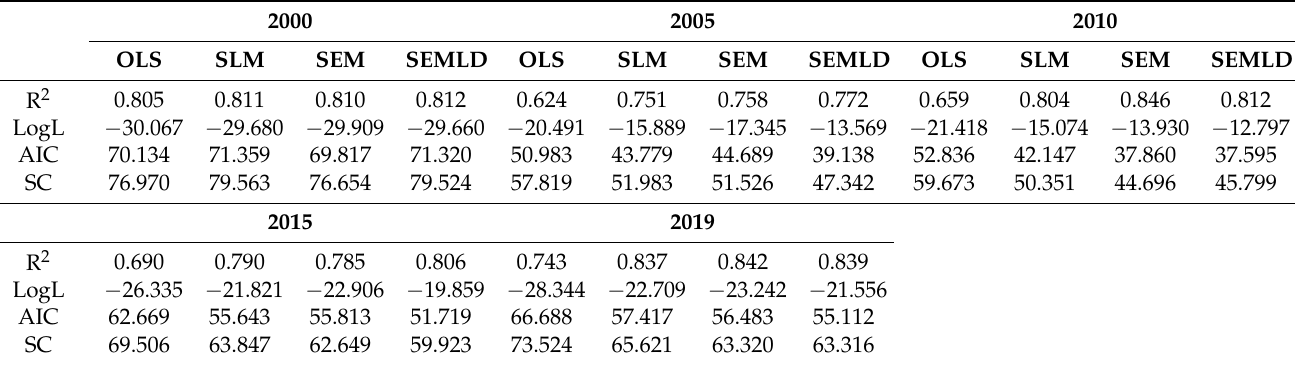
Table 6. Spatial regression results for CO 2 emissions per unit GDP in China (five-time